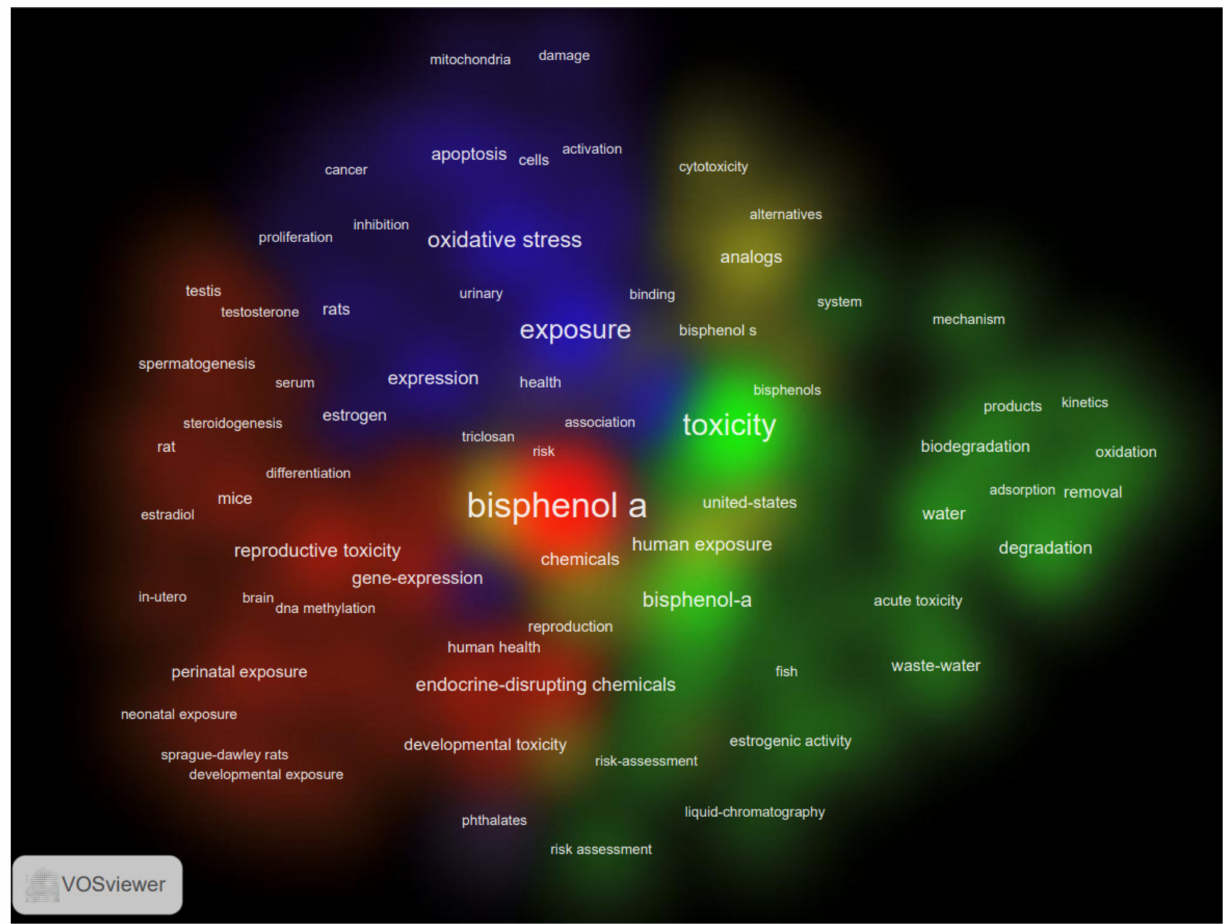
Figure 7. Cluster density of “BPA toxicity” co-occurrence